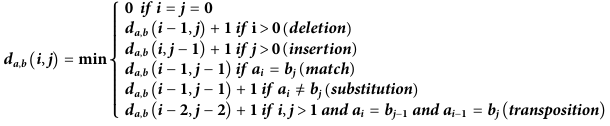
Frontiers in Genetics |